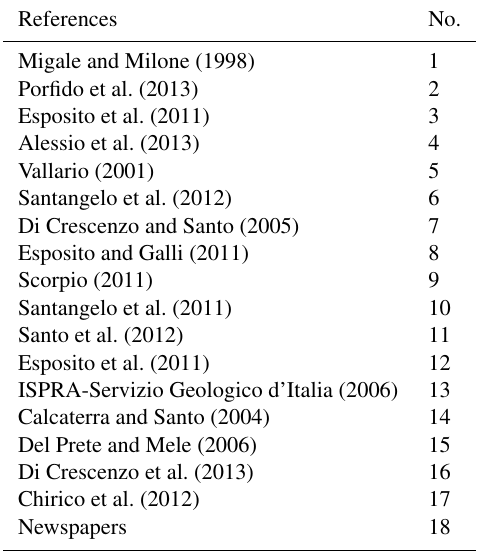
Table 2. References used in Table 1 (R